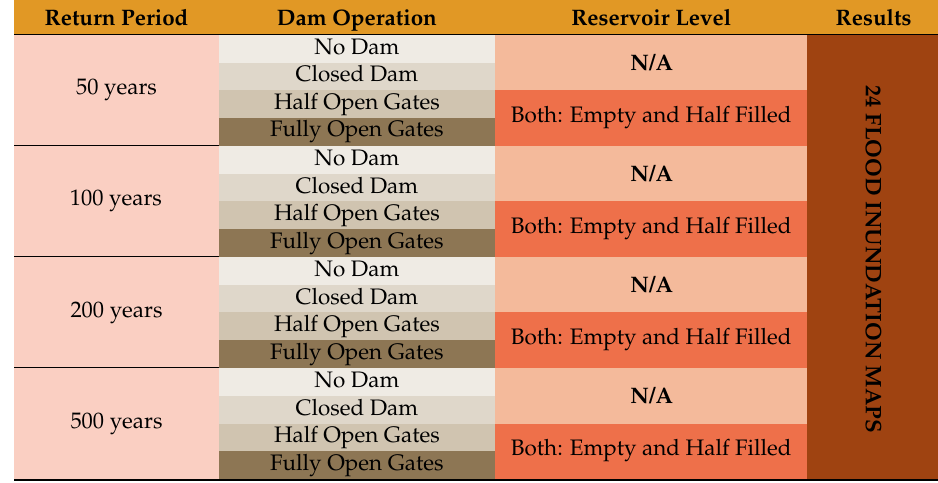
Table 2. Dam operation scenario